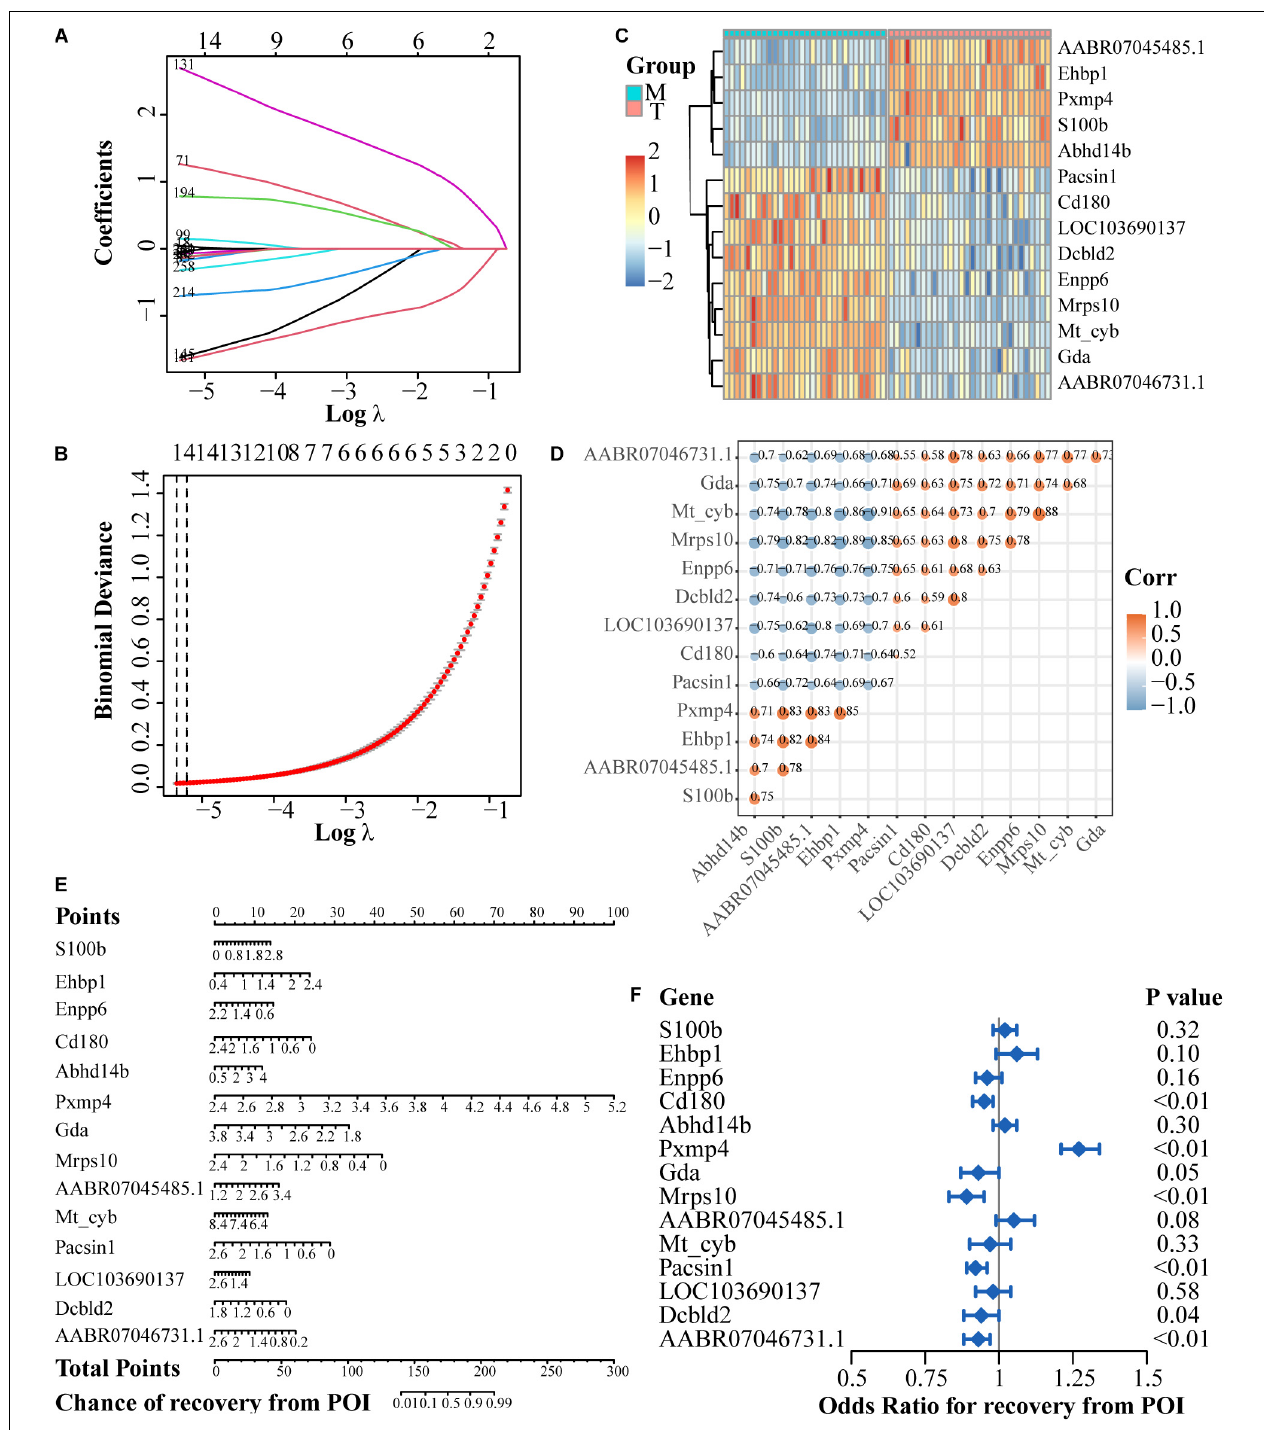
FIGURE 6 | Regulatory network establishment based on DEGs after rhGH treatment, compared with the model group. (A) Lasso coefficient profiles of the rhGH-treatment-related mRNAs. Each curve corresponded to a gene. (B) Partial likelihood deviance was calculated by the cross-validation for the best lambda to determine the minimum mean cross-validated error. (C) Expression heatmap of the 14 hub genes. (D) Expression correlation among the 14 genes. Color and size of dots indicated the degree of relevance among each gene (in other words, the larger the size, the higher the correlation), which were retained only when the P -value of correlation coefficient was less than 0.05. (E) Nomogram of the hub genes. The total points were applied for evaluating the possibility of the improvement of oocyte quality. (F) Forest plot for the odds ratio for recovery from POI of the 14 hub genes, selected by regression analysis.